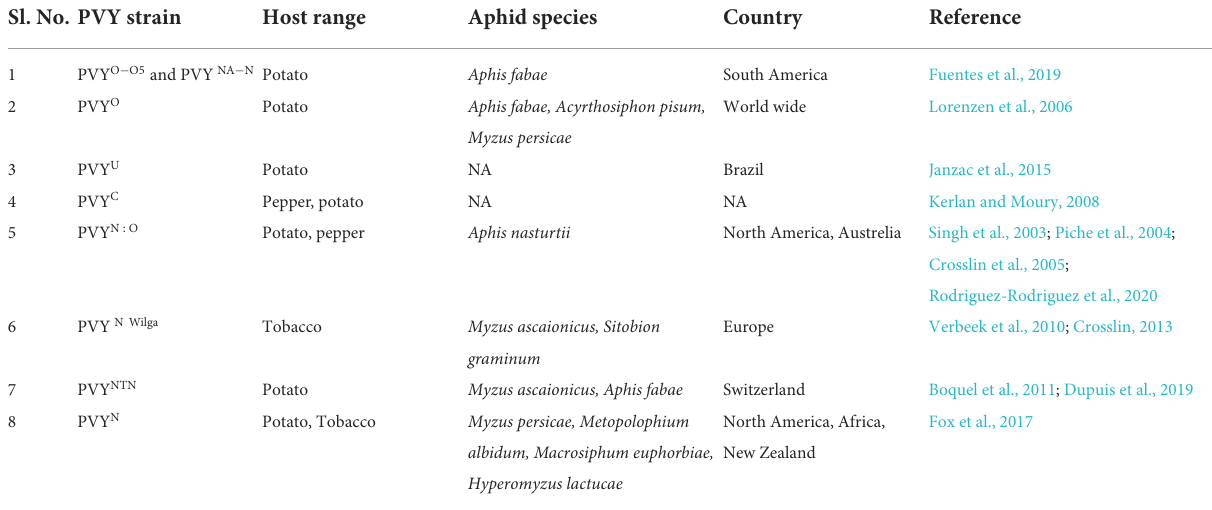
TABLE 1 Aphid species that transmit PVY and their host range. Sl. No. PVY